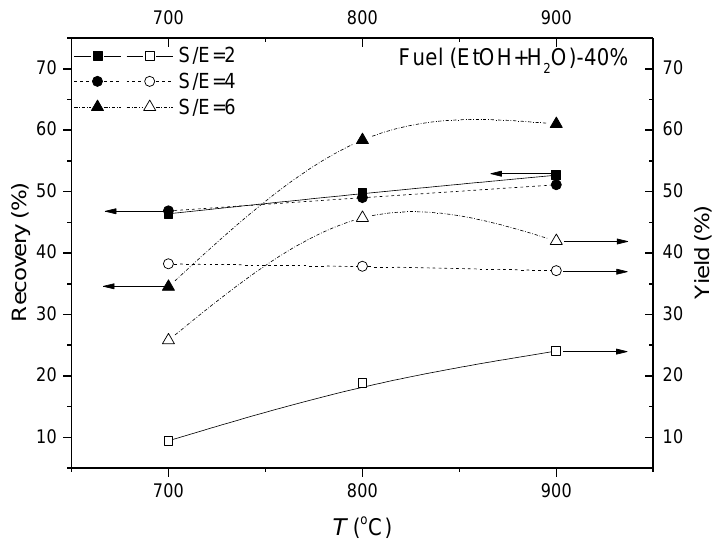
Figure 15. Effect of the operating temperature on the reactor efficiency characteristics for amount of the fuel mixture in Ar of 40%.